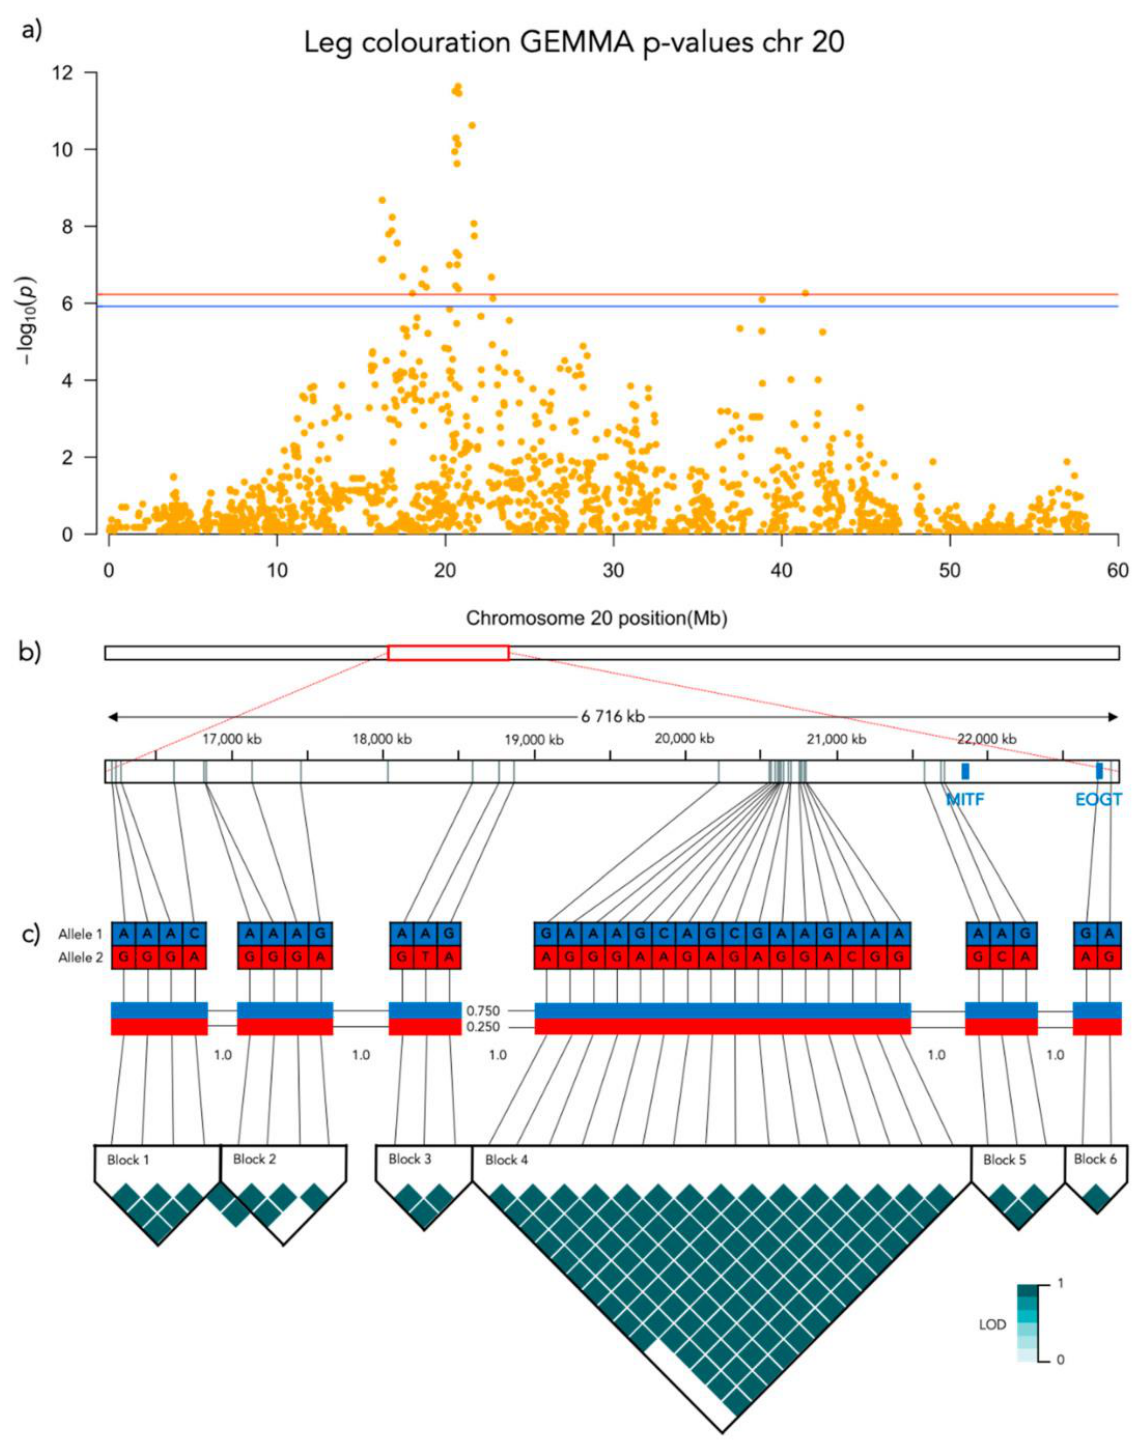
Figure 6. Results from the Genome-Wide Association analysis on the leg coloration phenotype for chromosome 20. ( a ) Manhattan plot of the chromosomes with significantly associated markers. The red line represents genome-wide significance of Bonferroni 5% and the blue 10%. ( b ) (upper) A schematic figure of the size and positioning of the significant region on the chromosome. (lower) Zoomed figure of the associated region showing the positioning of the significant SNP markers in grey and genes in blue. ( c ) Linkage disequilibrium heat map and haplotype blocks of the significant